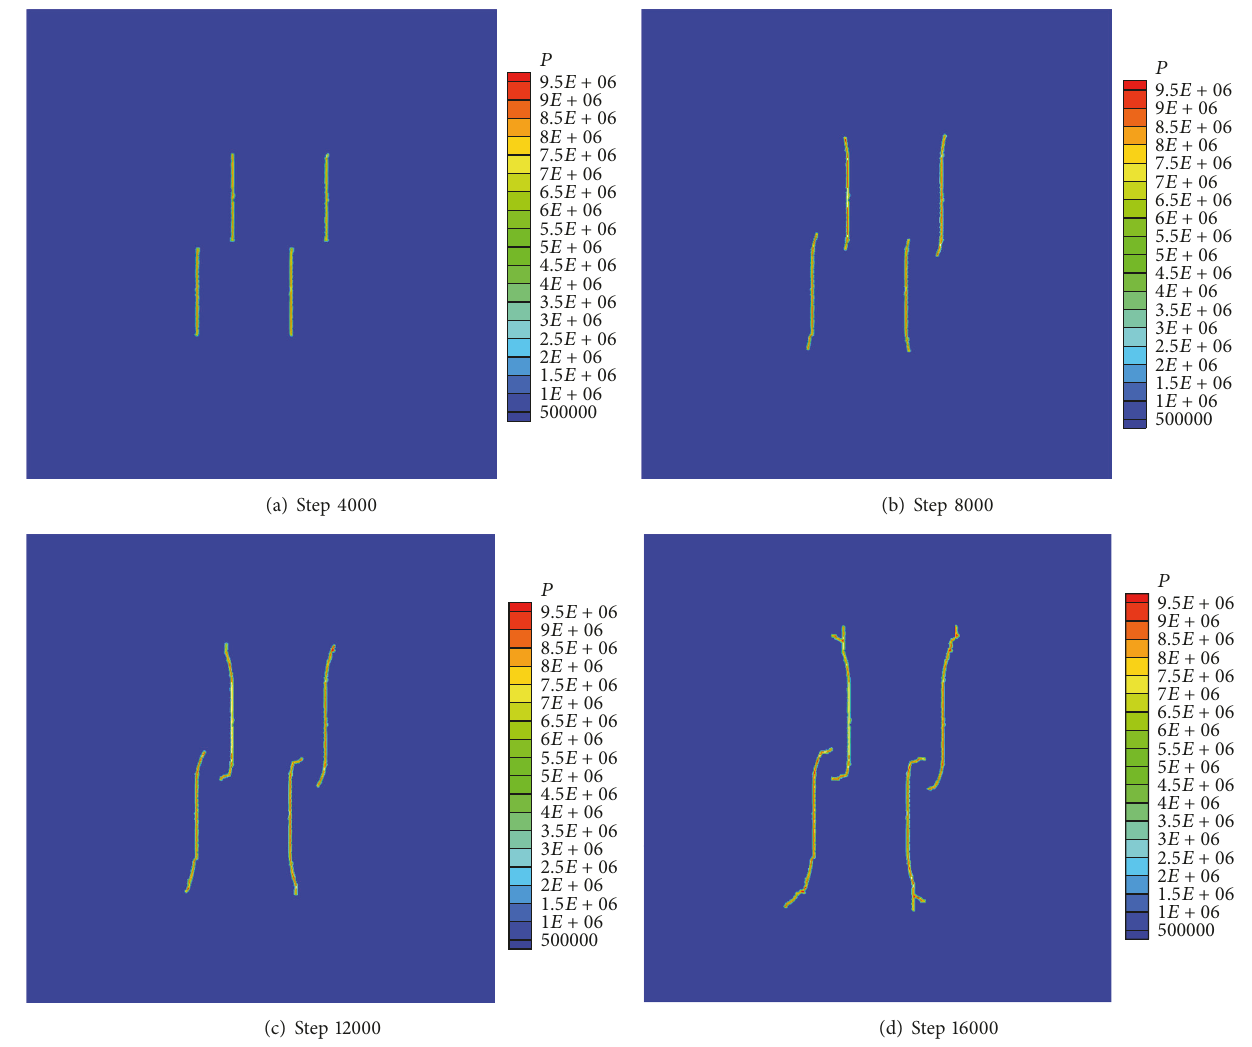
Figure 28: Evolution of fracture geometries and the distribution of fluid